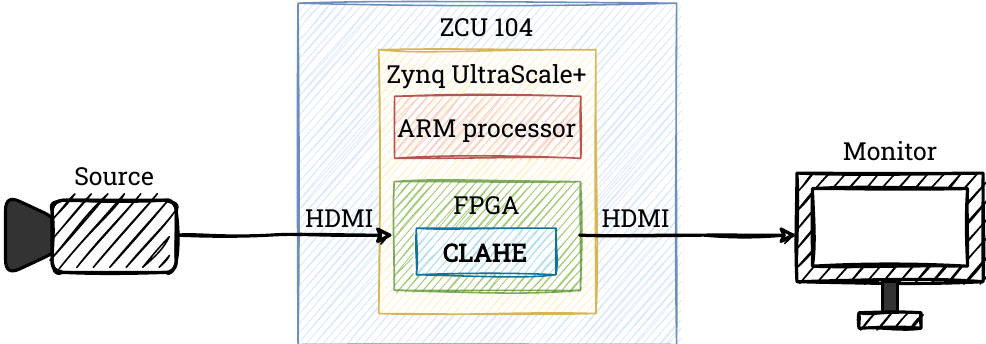
Figure 9. Simplified scheme of the system architecture. We use an HDMI source (camera/PC) and sink (UHD LCD monitor). All computations are performed in the PL/FPGA part of the used Zynq UltraScale+ MPSoC